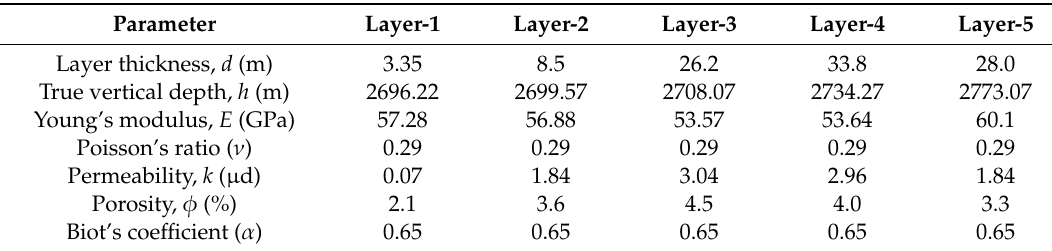
Table 1. Physical properties of the reservoir rocks in di ff erent layers.